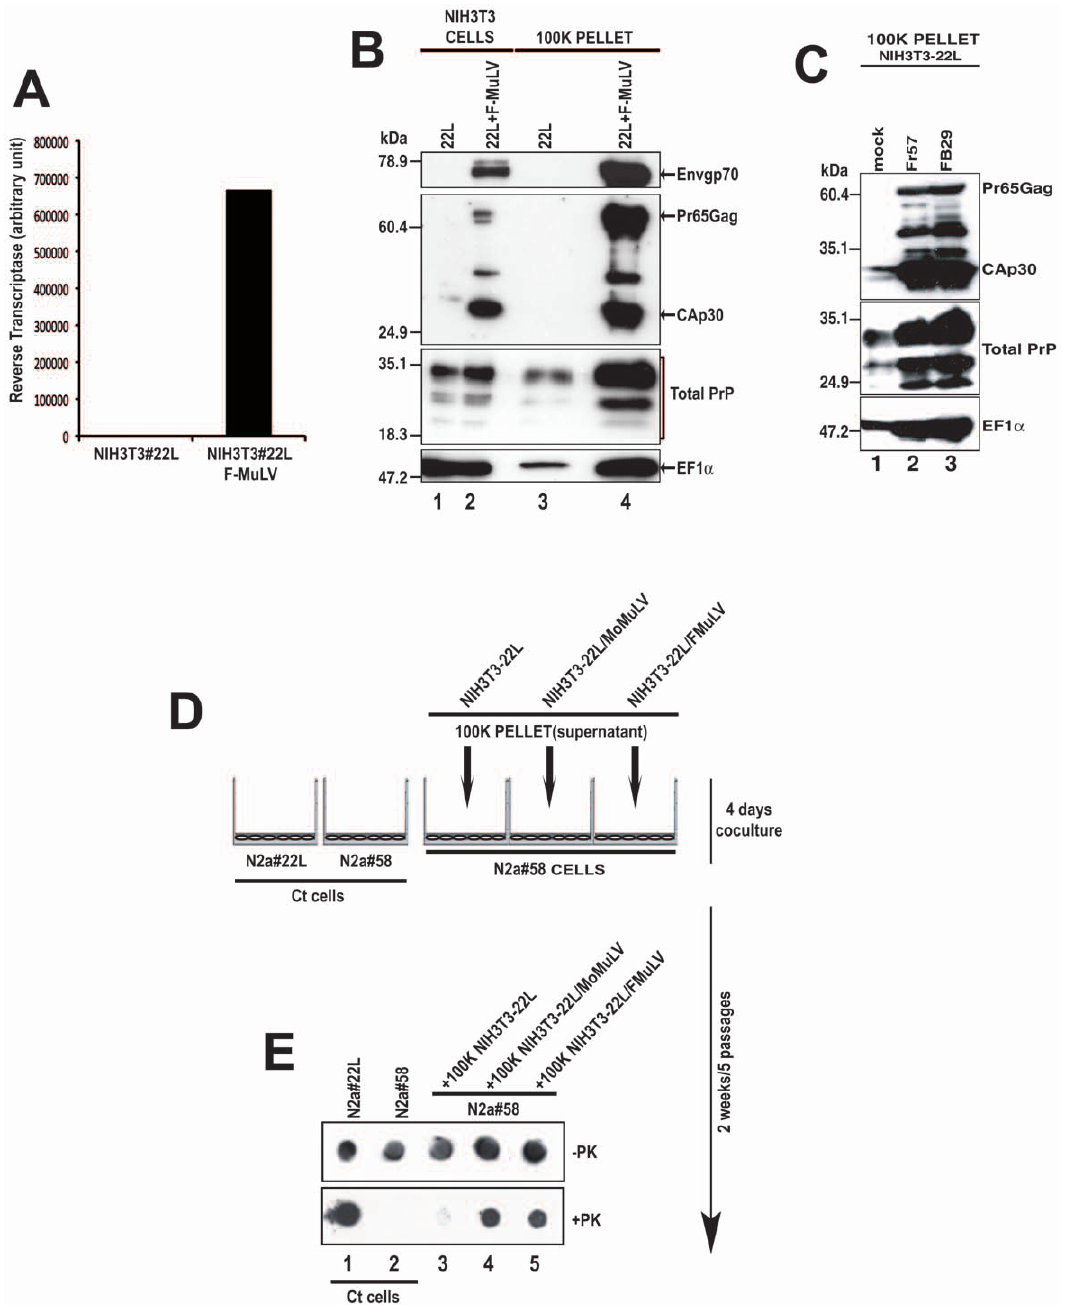
Figure 1. The Friend Murine Leukemia Virus (F-MuLV) strongly enhances PrP levels and prion infectivity released into the cell culture supernatant. ( A ) Reverse transcriptase (RT) levels in NIH3T3-22L cells alone (22L) and NIH3T3 cells coinfected with the F-MuLV strain FB29 (22L + F-MuLV). ( B ) NIH3T3-22L (lane 1) and NIH3T3-22L/F-MuLV cells (lane 2) were assayed for F-MuLV expression using the DJ-39462 antibody for the viral envelope (Envgp70, Panel 1) and the DJ-39461 antibody for the viral capsid (CAp30, panel 2). PrP was detected using SAF-32 (Total PrP, panel 3) and exosomes using anti-EF1 a (panel 4). The proteins recognized are indicated on the right side of the figure. Molecular mass markers are shown on the left side of the panel and lane numbers are indicated on the bottom of the figure. ( C ) NIH3T3-22L cells (mock) or NIH3T3-22L cells co-infected with the Friend viruses Fr57 or FB29 were analyzed by western blot for F-MuLV expression as well as PrP and exosome release as in panel B. Note that the F-MuLV Fr57 strain, like FB29, strongly enhances PrP and exosome release. Molecular mass markers are shown on the left side of the panel and lane numbers are indicated on the bottom of the figure. The proteins recognized are indicated on the right side of the figure. ( D ) Coculture assay. Uninfected target N2a # 58 neuroblastoma cells grown on the bottom surface of a six well plate and a 0.4 mm pore size insert containing the 100 K pellet from the supernatants of NIH3T3-22L, NIH3T3-22L/MoMuLV or NIH3T3-22L/F-MuLV were cocultured for 4 days. The N2a # 58 target cells were then passaged 5 times over 2 weeks and assayed for PrP Sc . Ct=control. ( E ) Total PrP (-PK) and PrP Sc ( + PK) levels in N2a58 cells co-cultured with NIH3T3-22L/MoMuLV or NIH3T3-22L/F-MuLV supernatants were analyzed by dot blot. Ct cells=22L infected and uninfected N2a # 58 cells not exposed to supernatant. Lane numbers are shown at the bottom of the panel.